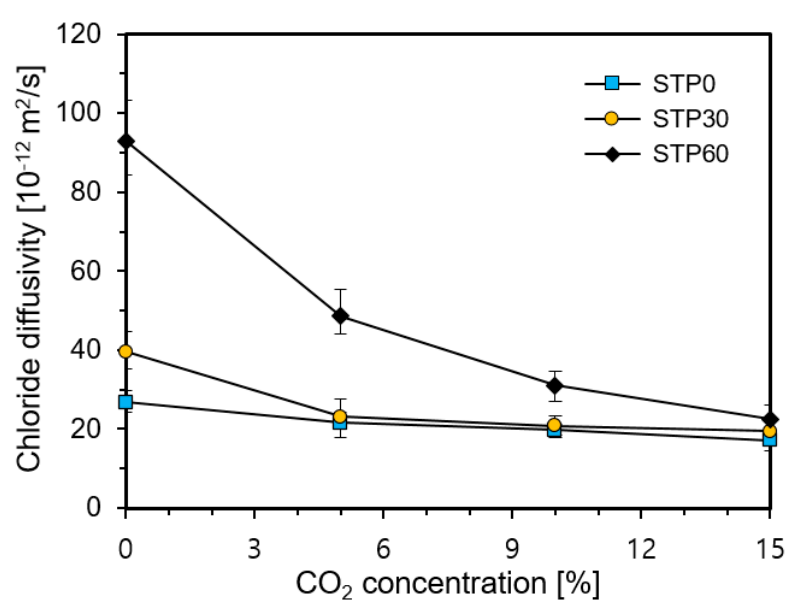
Figure 7. Chloride diffusivity according to CO 2 concentration.